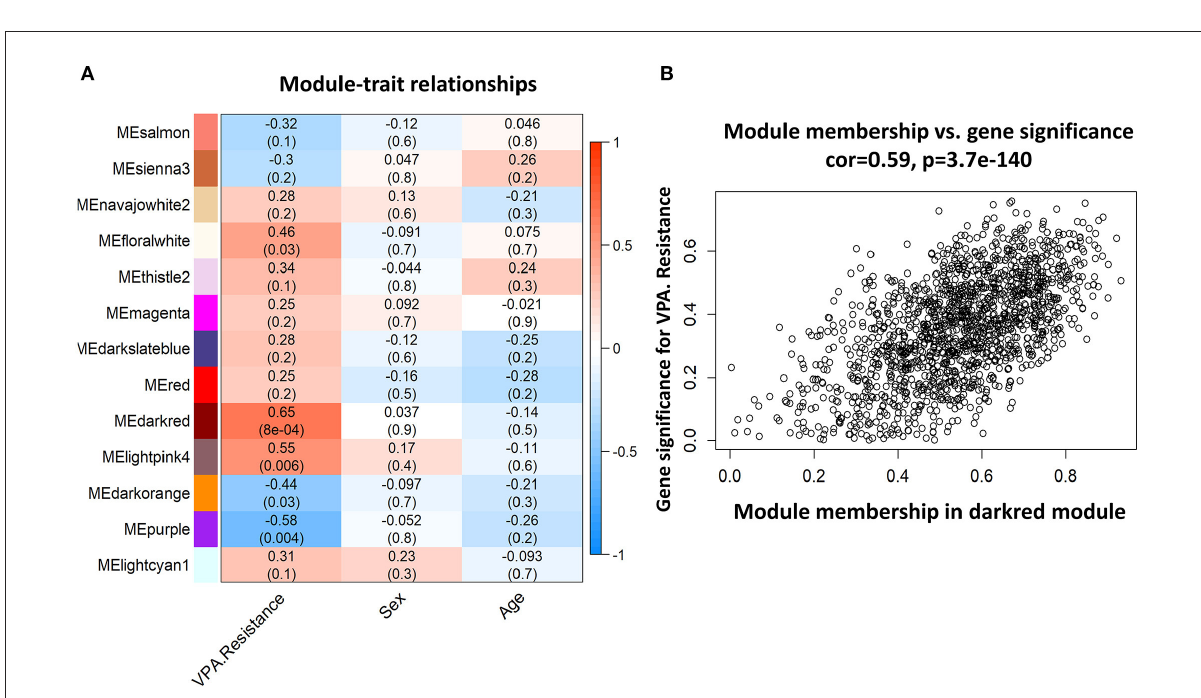
FIGURE5 Representative heat map of modules-traits relationship and analysis of gene significance and module membership in the darkred module. (A) The heat map showed the relationship between different modules and each trait (VPA resistance, sex, or age). The number in each bar denoted the correlation coefficient and p -value. The darkred module is most related to VPA resistance. (B) Scatter diagram to show the gene significance in VPA resistance and module membership in the darkred module (VPA,